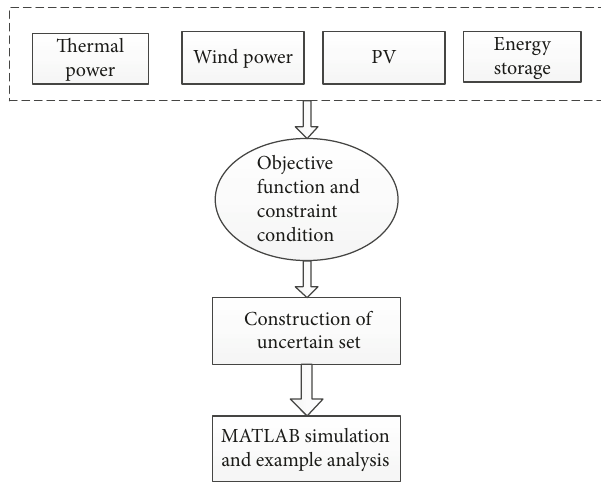
Figure 2: VPP bidding flow chart.